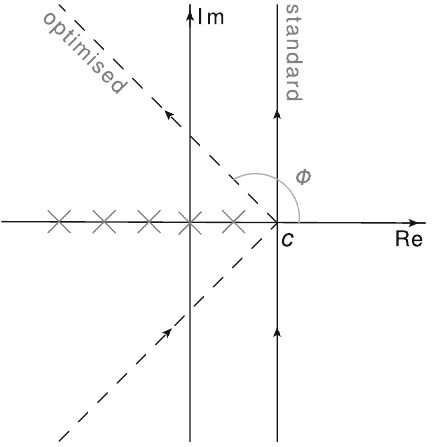
Fig. 2 Standard and optimised integration contours in the complex plane for the inverse Mellin transform. The two contours intersect the real axis at the point c , and the optimised contour is bent by an angle φ > π/ 2 with respect to the real axis. The crosses represent the poles of PDF parameterisation in Mellin